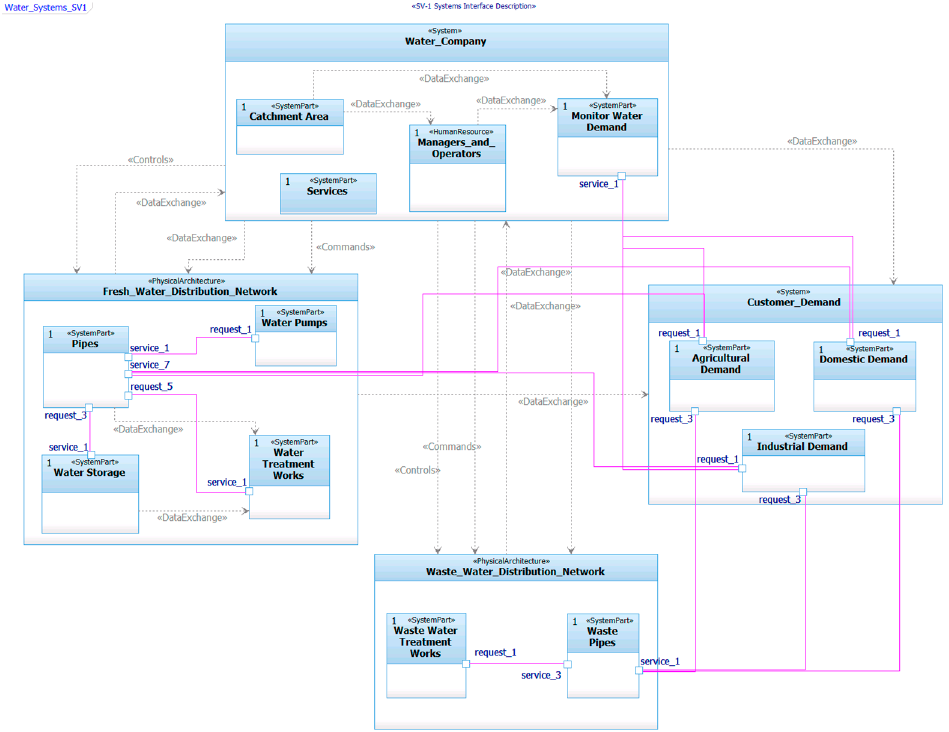
Figure 9. SV-1 Water Company systems .